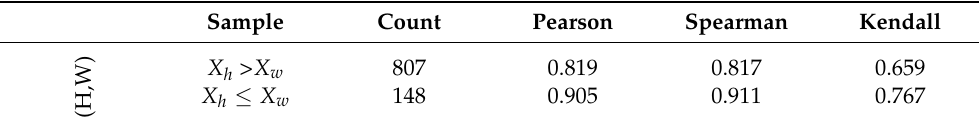
Table 4. Empirical dependence measures for the husband and wife sample, split by the sex of the elder spouse, where X h represents the lifetime of the husband and X w the lifetime of the